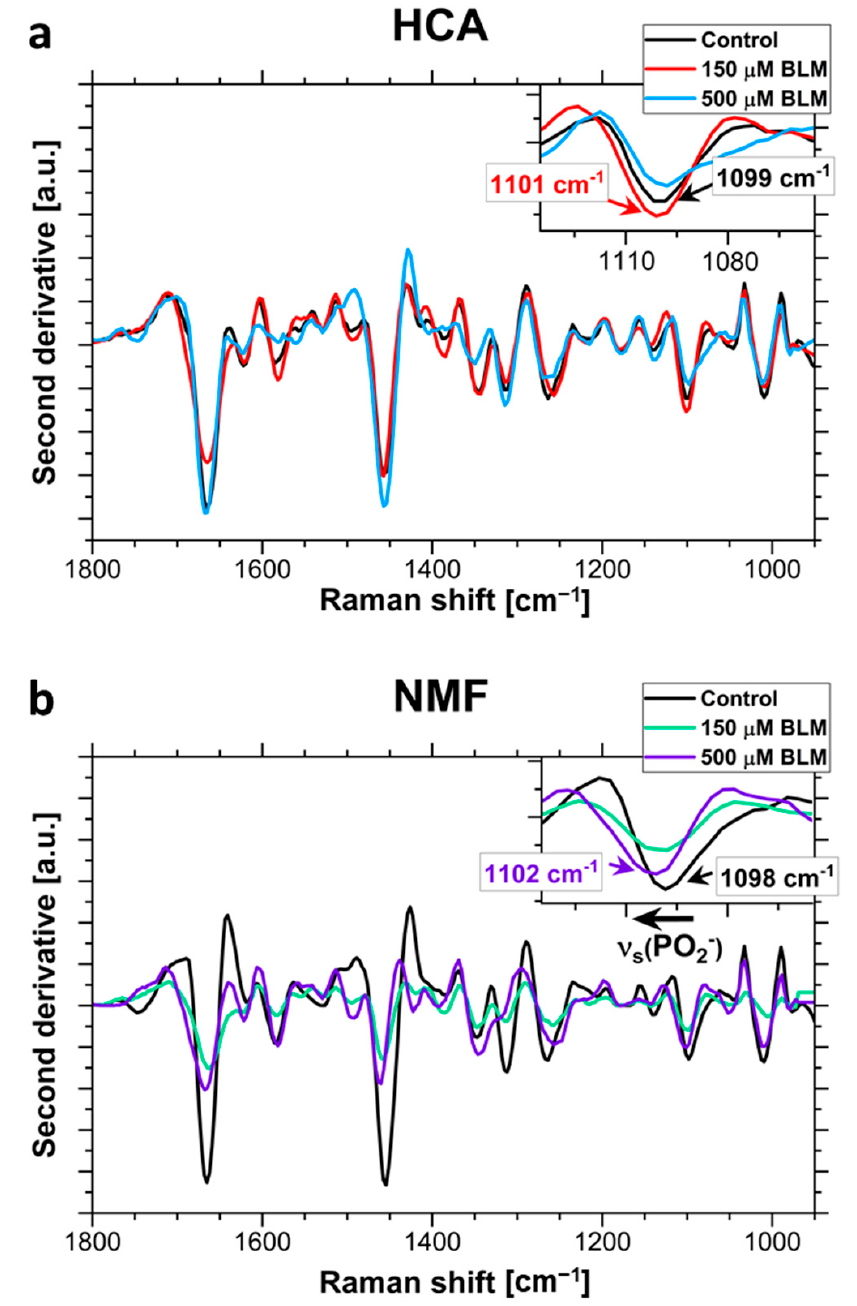
Figure 5. Monitoring of DNA conformational transitions in selected cell nuclei: ( a ) Second derivatives of Raman spectra extracted via HCA from nuclei region of HeLa cells. Zoomed spectral region attributed to ν s(PO 2 − ) is demonstrating shifts resulting from the conformational change from B-DNA to A-DNA. ( b ) Second derivatives of NMF components corresponding to signal from the nuclei area of HeLa cells. Zoomed spectral region attributed to ν s(PO 2 − ) is demonstrating shifts resulting from the partial conformational changes from B-DNA to A-DNA.